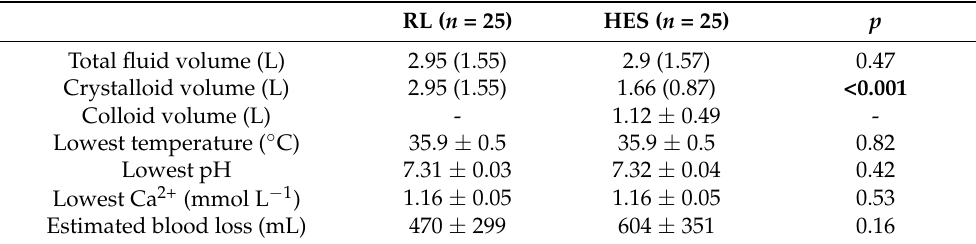
Table 2. Intraoperative variables: fluid volumes, possible confounding factors to hemostasis, and estimated blood loss. Values are median (IQR) or mean ± SD as appropriate.